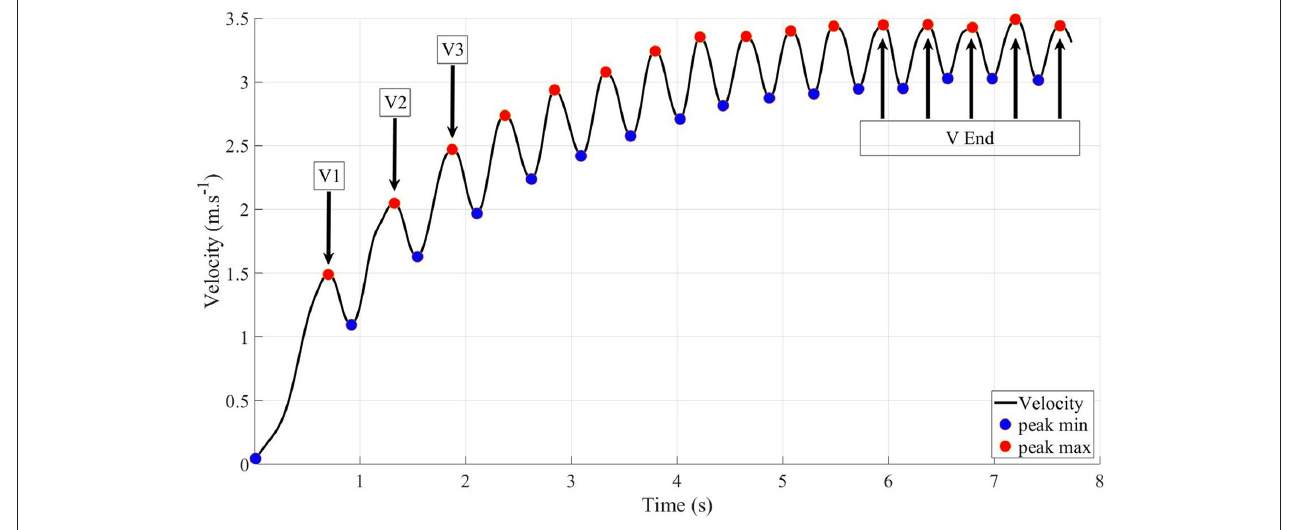
FIGURE 2 | The first three peak velocities (V1, V2, and V3) on the acceleration phase and five peak velocities (V End) on the constant peak velocity phase (2).